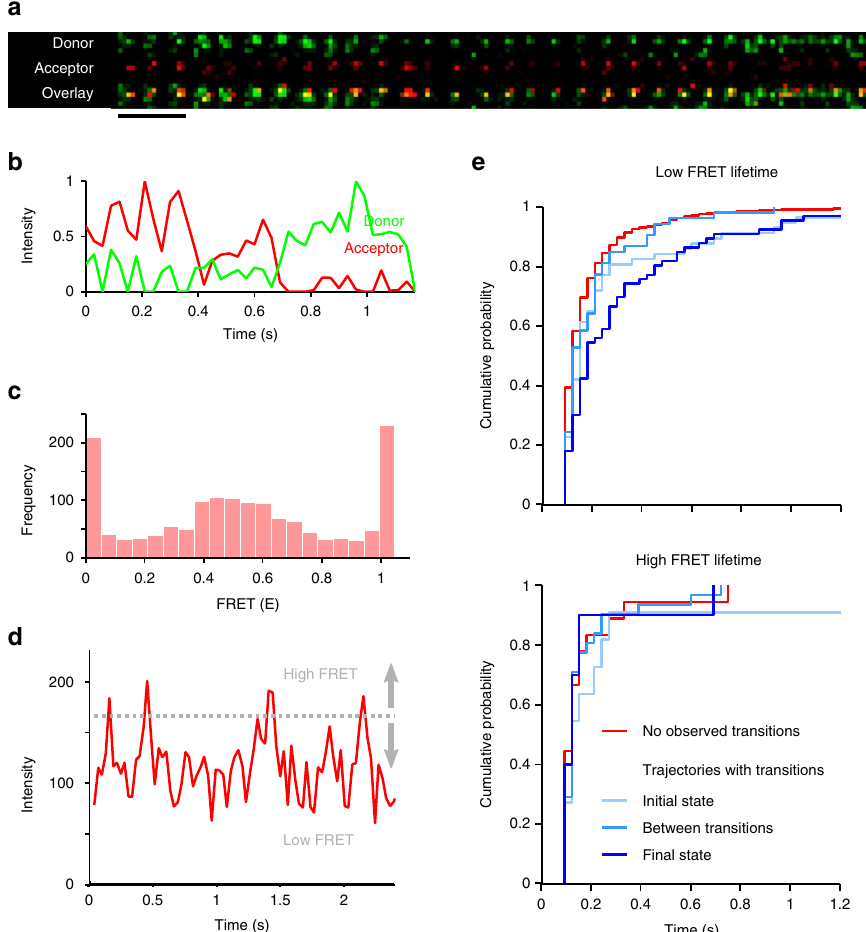
Fig. 4 Single-molecule FRET dynamics. a Sequential frames (30 ms per frame) of part of a single NTS1 dimer trajectory observed by single-molecule FRET. Donor (green) and acceptor (red) channels together with their overlay (registered to nearest pixel) show temporal fl uctuation in FRET in the dimer species (note, relative contrast is set to illustrate both channels in overlay). Scale bar: 5 μ m. See also Supplementary Movie 5. b Representative NTS1 dimer fl uorescence traces (green: donor, red: acceptor, see also Supplementary Fig. 9) illustrate temporal fl uctuation within a single dimer trajectory; donor and acceptor fl uorescence intensities are anti-correlated. c FRET ef fi ciency histogram from 40 dimer trajectories shows a broad distribution of FRET ef fi ciencies consistent with high and lower acceptor fl uorescence intensity populations, suggesting multiple dimerisation interfaces. d Fluorescence intensity of the acceptor in a dimer species is shown for a single dimer trajectory (see also Supplementary Fig. 8). A bimodal acceptor fl uorescence intensity distribution, showing high- and low-FRET states, was measured for NTS1 dimers in single-molecule experiments (Fig. 2b and Supplementary Fig. 8). Rather than observing dimer trajectories with acceptor fl uorescence intensities at either low or high levels, the acceptor fl uorescence intensity showed changes within trajectories, suggesting that the bimodal acceptor fl uorescence intensity distribution (Fig. 2b) is a result of dynamic interconversion between different dimerisation interfaces. Interconversion between high- and low-FRET states was analysed. A conservative threshold was de fi ned (166.5 counts — grey dashed line in d , see also Supplementary Fig. 8), above which intensities have <1% probability of belonging to the low-FRET state. e Lifetime